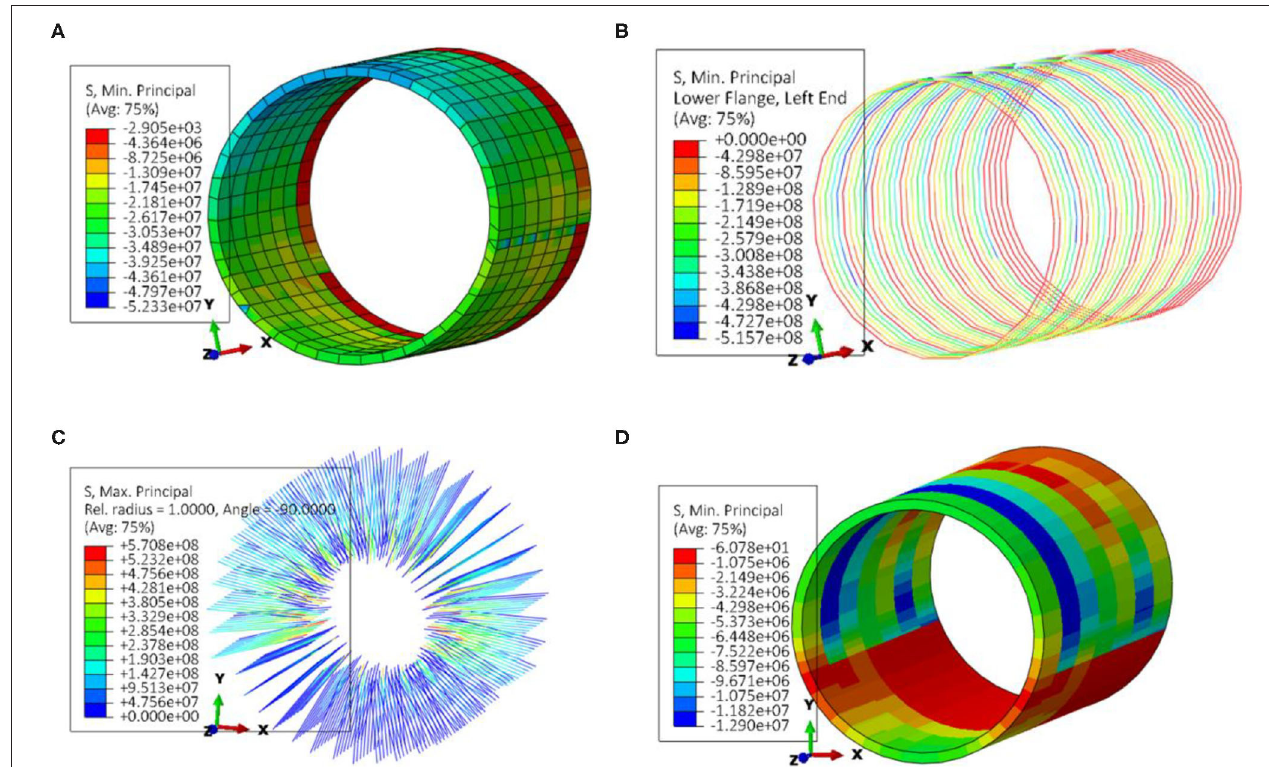
FIGURE 12 | Simulated results: (A) Initial support (B) Steel arch (C) Anchor rod (D) Secondary lining (Unit: Pa).